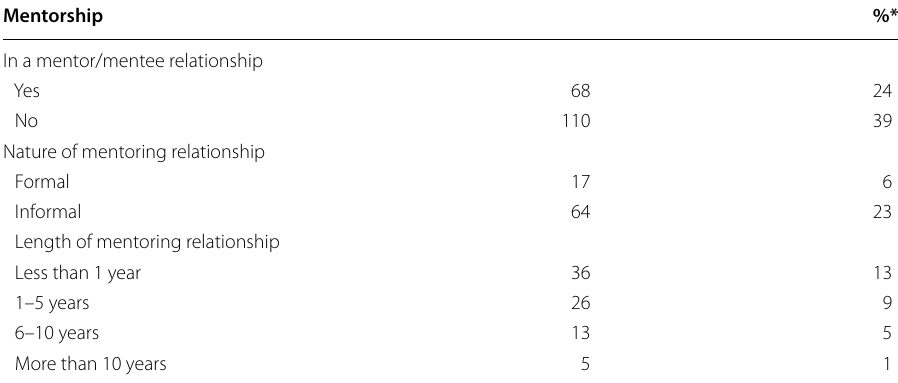
*Percentages will not reflect the total sample as all questions did not require a